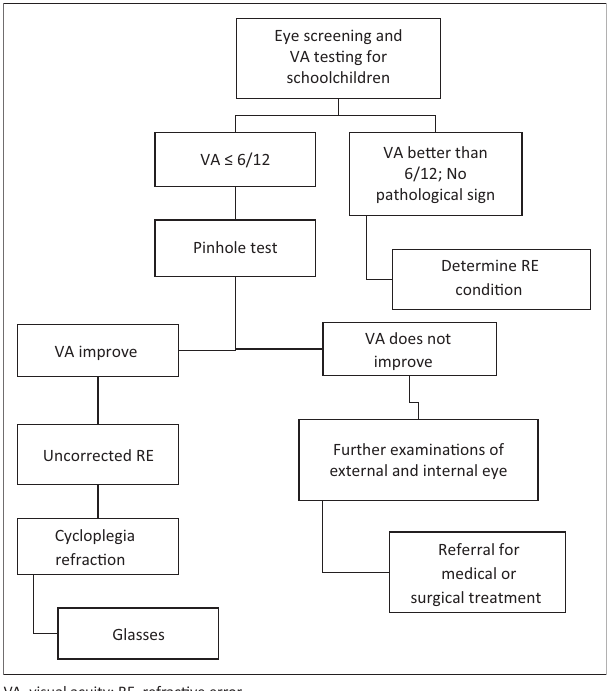
FIGURE 1: Chart illustrating the procedures for assessing vision and detecting vision impairment. TABLE 1: Distribution of uncorrected visual acuity for right, left and better eye and best-corrected visual acuity by percentage and confidence interval.